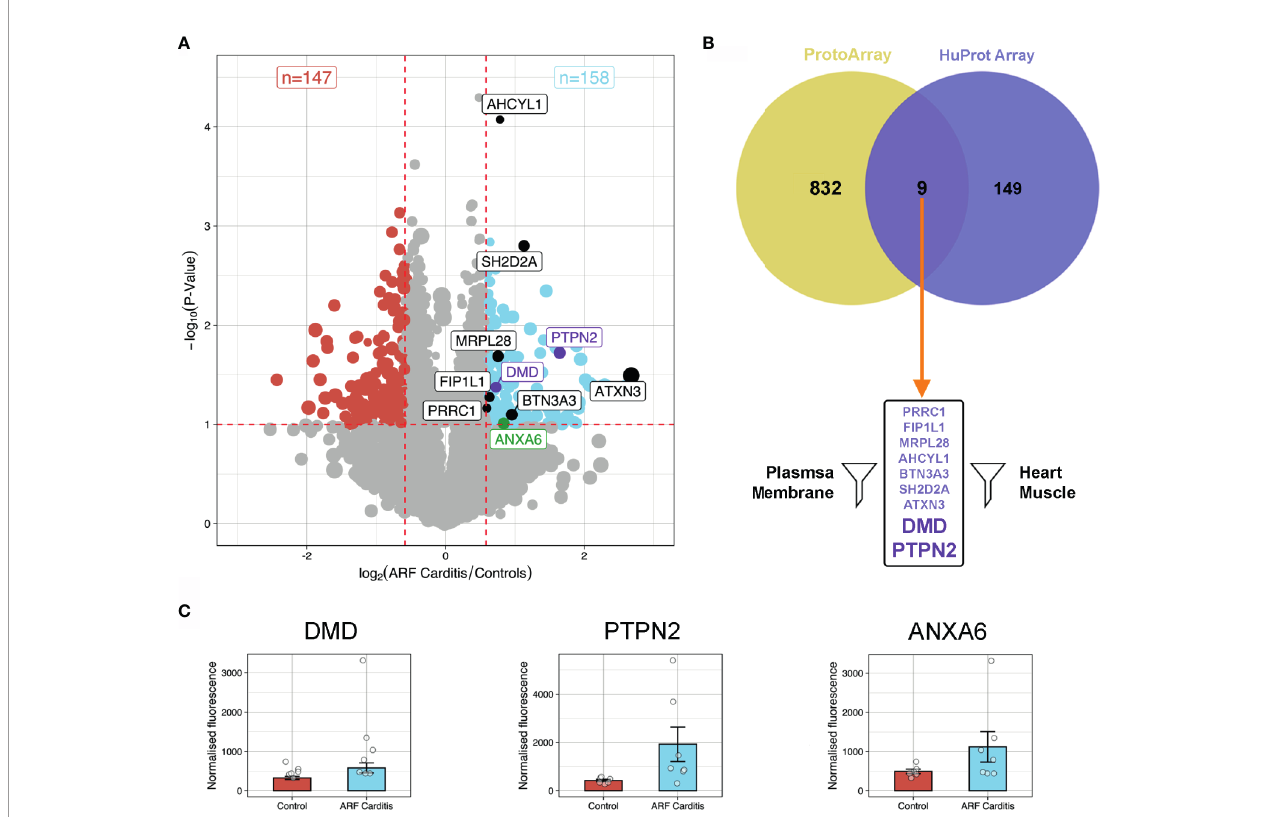
FIGURE 3 | Autoantibody cross-validation using HuProt array (A) Volcano plot showing fold-change differences in autoantibody signals between ARF patients with carditis (n=7) and healthy controls (n=6). The size of the dots relates to the fl uorescence intensity of individual autoantibodies. Red dashed lines indicate cut-offs for signi fi cant differences (p < 0.1, fold-change >1.5). Blue dots represent autoantibodies showing signi fi cantly increased binding in ARF patients compared to controls whilst red dots represent autoantibodies showing signi fi cantly increased binding in controls compared to ARF patients. Black and purple annotated autoantibodies are those also identi fi ed in ProtoArray analysis (see Figure 2 ), with purple dots relating to novel autoantibodies of interest for downstream analysis. Green annotated dot was also identi fi ed by 2-DE gel. (B) Venn diagram showing the nine overlapping autoantibodies between; 158 proteins identi fi ed in HuProt analysis from part (A) in violet; and 841 autoantibodies identi fi ed in ProtoArray analysis from Figure 2A in yellow. Following fi ltering for proteins localized to plasma membrane and present in heart muscle, autoantibodies targeting two proteins were identi fi ed indicated by large purple text. (C) Bar graphs showing mean and standard error of normalized fl uorescence values representing autoantibody reactivities to DMD (left), PTPN2 (middle) and ANXA6 (right), from healthy controls (blue, n=6) and ARF patients with carditis (red,